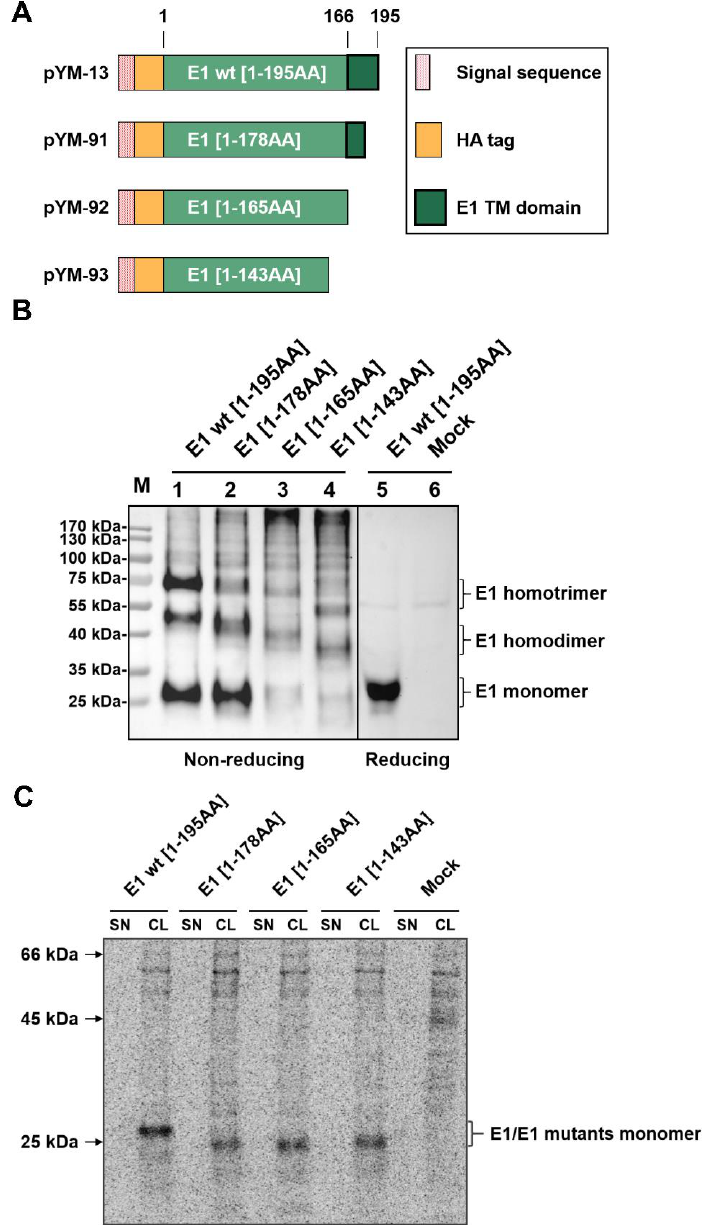
Figure 1. E1 forms homooligomers independent to its membrane anchor. ( A ) Schematic representation of HA-tagged E1 wt/C-terminally truncated E1 proteins expressed from the constructs. The box on the right gives the meaning of the differently designed bars [red dotted bar: E rns signal sequence fused to the E1 sequences (green bars) with the length of the sequences given]. A HA-tag (orange bar) was introduced in between the signal sequence and the E1 sequence for the detection of E1. The black frame represents the putative transmembrane region of E1. ( B ) The HA-tagged E1 and its truncated variants were expressed in RK-13 cells, and expression products were analyzed via western blot on the following day. The cells were lysed with lysis buffer without ( left ) or with ( right ) β-mercaptoethanol, aliquots of the lysates loaded onto SDS gels and separated electrophoretically. Western blot analysis was carried out using primary antibody α-HA and PO-labeled second antibodies for the detection of protein. For each lane, the length of the expressed E1 sequence is given on top. Molecular weight of the size marker bands given on the left. As a supplement, we provide a file with the original western blot results to demonstrate that the two parts were derived from one gel. ( C ) The HA-tagged E1 expression plasmids were expressed in BHK-21 cells using the Vaccinia virus MVA T7 expression system [23,30,31], and the empty pCI empty vector served as a mock control. Expressed proteins were labelled with 35 S amino acids. From supernatant (SN) and cell lysates (CL) of the transfected cells, proteins were precipitated with a specific HA-tag antiserum, separated by SDS-PAGE under reducing conditions detected on imaging plates. Molecular weight of the size of the marker bands given on the